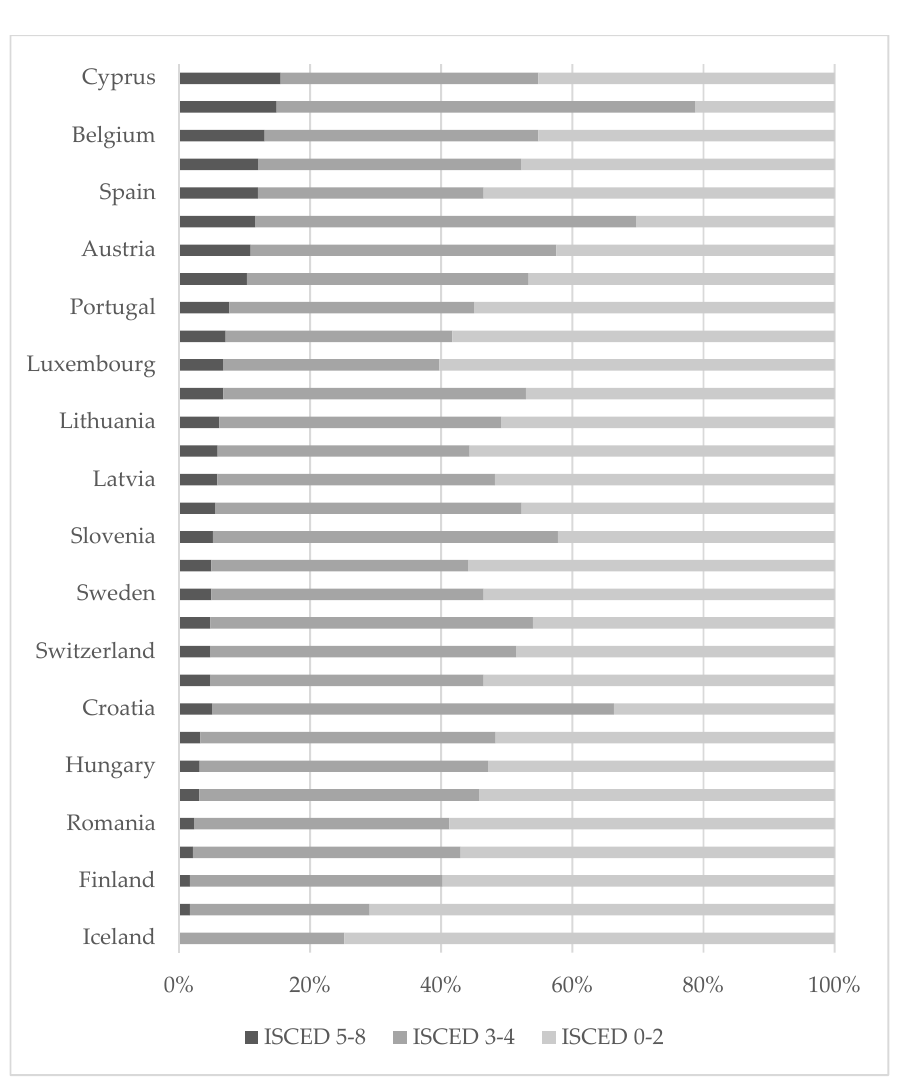
Figure 3. Educational attainment of rural youth, 15–24 years (average 2010–2019, percentages).Data for tertiary education for 15–24-year-olds in rural Iceland are not available (confidential) in the Eu- rostat data (hence the 0% ). There are data for 30–34-year-olds in rural areas: 36.9% had higher edu- cation (average for 2010–2019), but this rate is significantly lower than the average for the urban population (54.9%). In Iceland as a whole, a very small proportion (between 1.5 and 3.8%) of